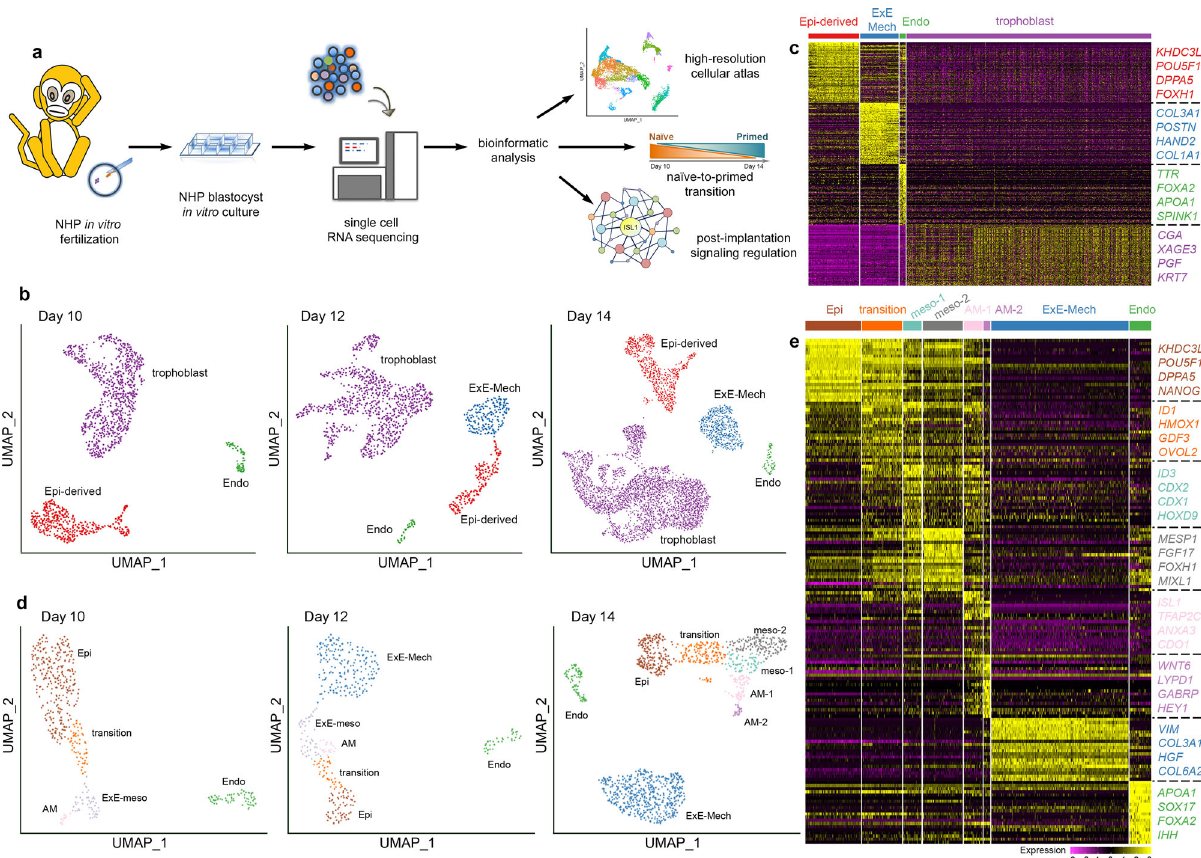
Fig. 1 High-resolution transcriptomic map of peri-gastrulation events in wild-type in vitro cultured NHP embryos. See also Supplementary Figs. 1 – 5 and Supplementary Data 1 – 3. a Scheme of the work fl ow. b UMAP plot of all cells from the in vitro cultured embryos at the different time points (Days 10, 12, and 14) colored by cell type. c Heatmap showing the scaled expression at Days 14 of 100 differentially expressed genes (DEGs) for each cell type identi fi ed in ( b ) selected by false discovery rate. d UMAP plot of cells from the in vitro cultured embryos at the different time points (Days 10, 12, and 14) mapping to the Epi and its derivatives, Endo and ExE-Mech colored by cell type. e Heatmap showing the scaled expression at Days 14 of 20 DEGs for each cell type identi fi ed in ( d ) selected by false discovery rate. Epi-derived epiblast and epiblast-derived cells, ExE-Mech extraembryonic mesenchyme, Endo